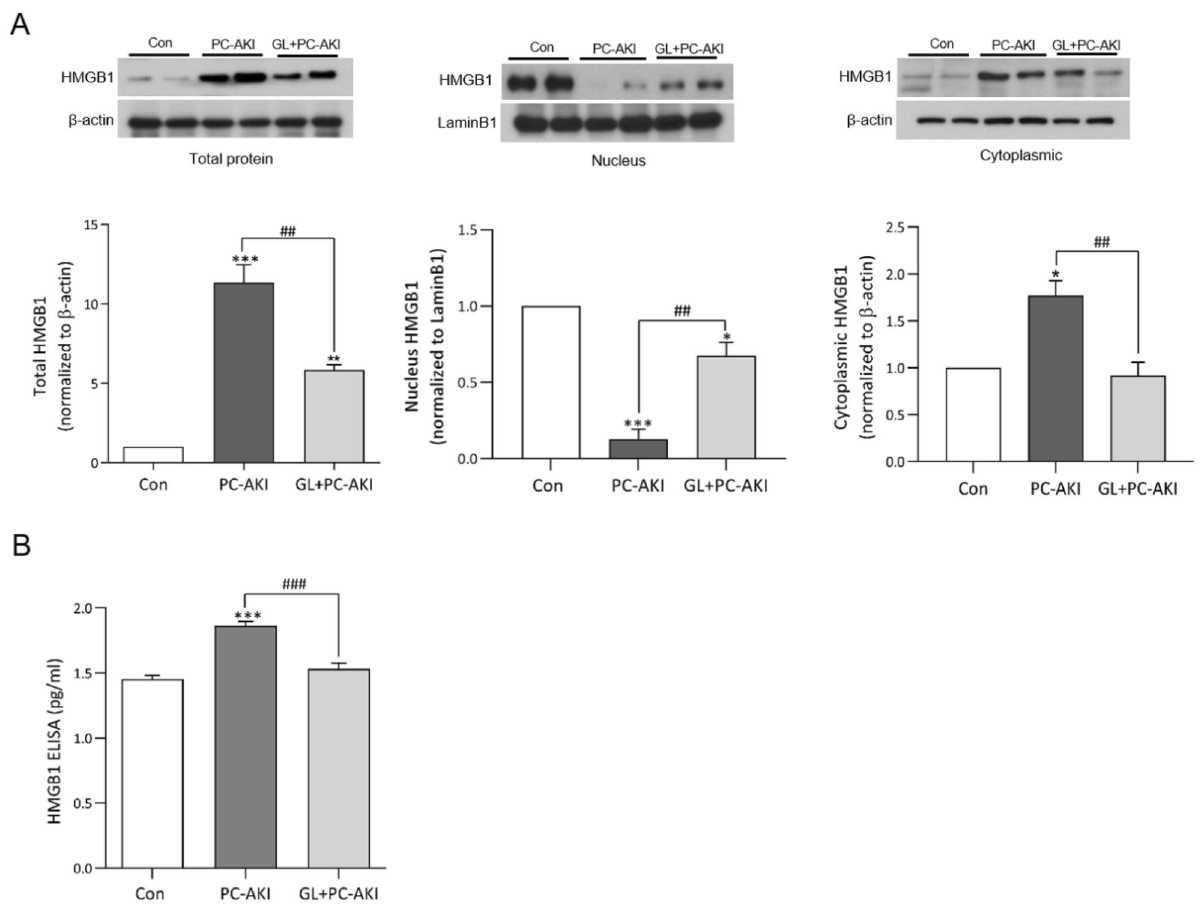
Figure 2. Effect of glycyrrhizin on HMGB1 protein expression. (A) Representative western blot bands of HMGB1 with intracellular total protein, nucleus and cytoplasmic protein isolation. Expression levels were normalized to β-actin. The expressions of intracellular and cytoplasmic HMGB1 were significantly increased in the PC-AKI group compared to the controls, and were significantly reduced in the PC-AKI with glycyrrhizin group. On the other hand, the expression of nucleus HMGB1 in PC-AKI group significantly reduced compared to the control, but was significantly increased PC-AKI with glycyrrhizin group. The β-actin was used as a cytoplasmic and intracellular marker and LaminB1 as a nuclear marker. (B) The serum HMGB1 measured by ELISA was significantly higher in the PC-AKI group compared to the controls, but was significantly lower in the PC-AKI with glycyrrhizin group. Images of blots were cropped. Full-length blots are presented in Supplementary Figure 1. Results were expressed as means ± SEMs. N = 8 for each group. Statistical significance: * P < 0.05, *** P < 0.001 Con vs PC-AKI and Con vs PC-AKI + GL, ## P < 0.01 and ### P < 0.001 PC-AKI vs GL + PC-AKI. Abbreviation: PC-AKI, post-contrast acute kidney injury; GL,